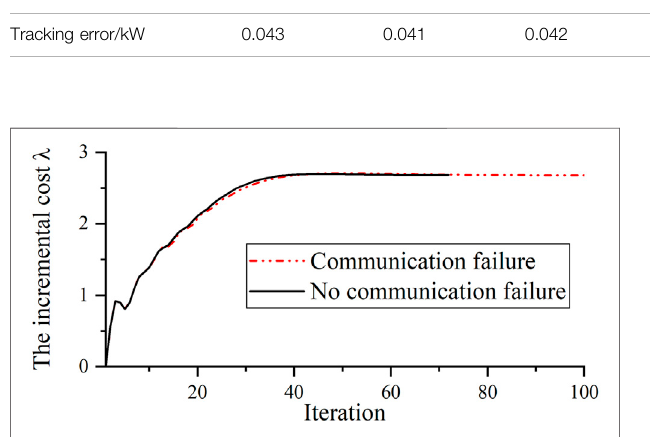
TABLE 6 | The mean absolute tracking error. Prediction error